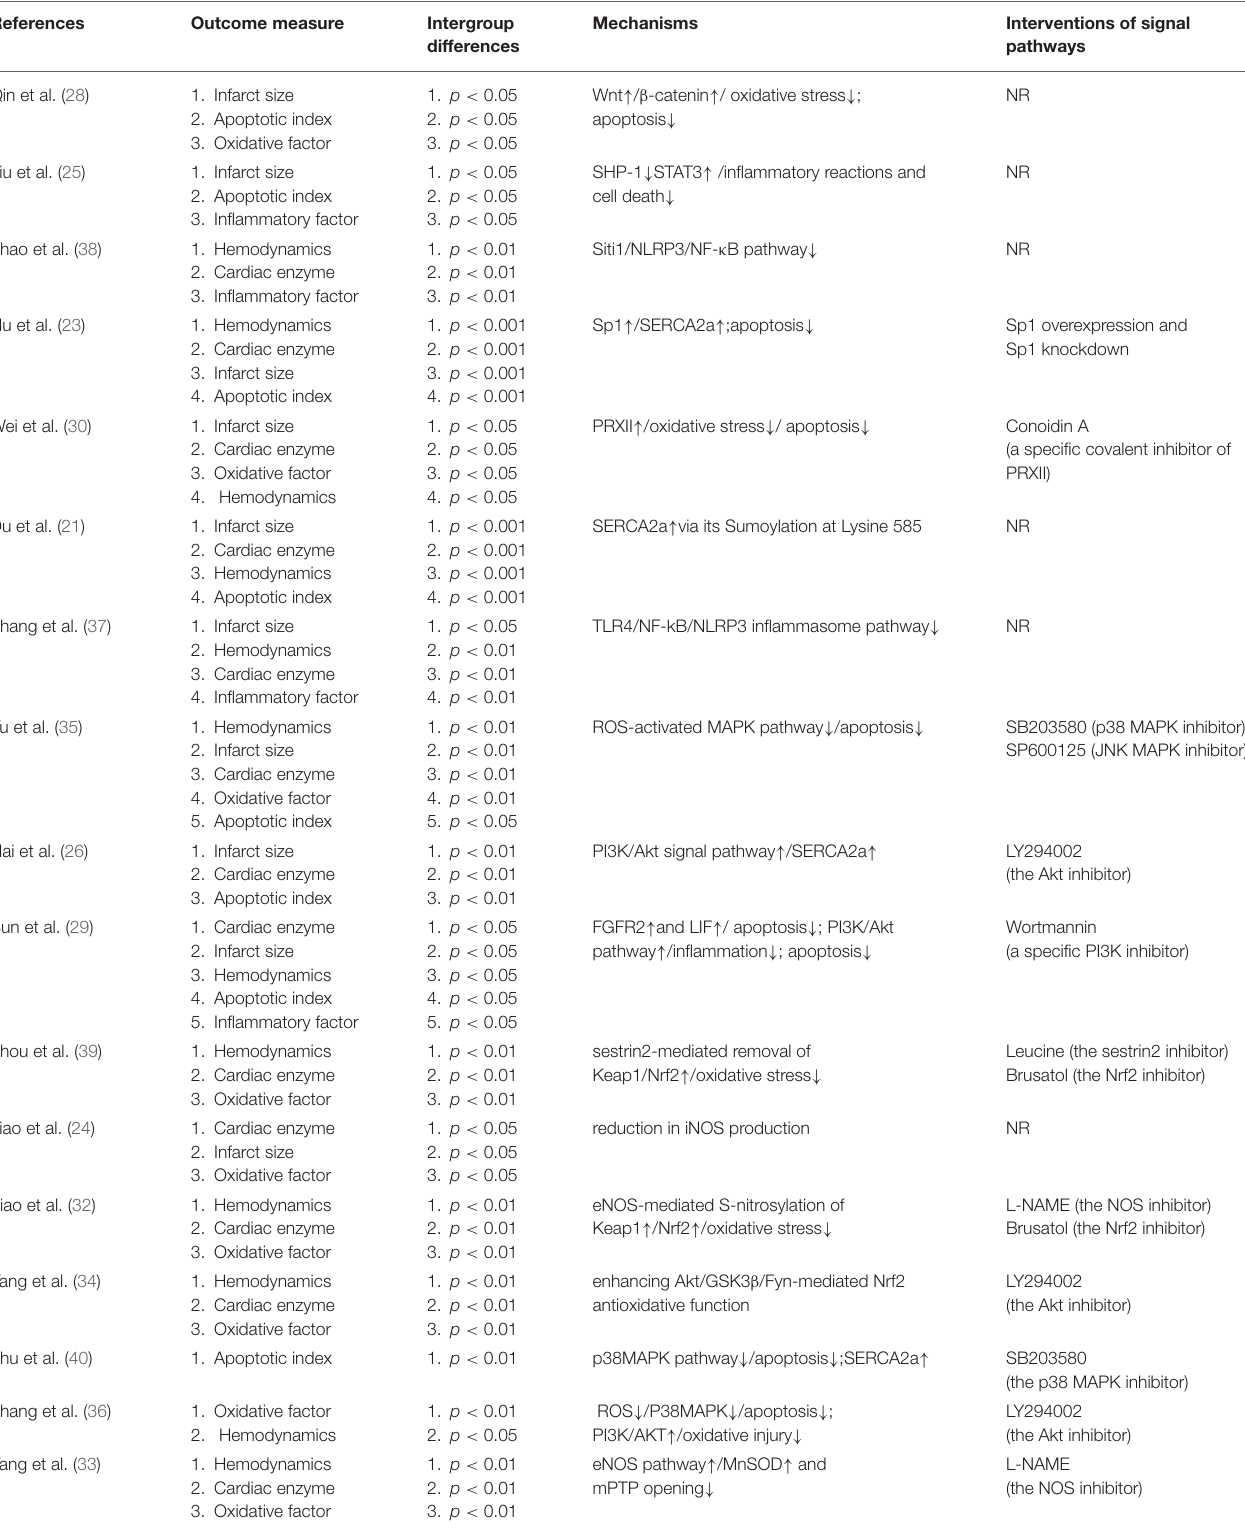
TABLE 2 | Summary of mechanisms of luteolin for